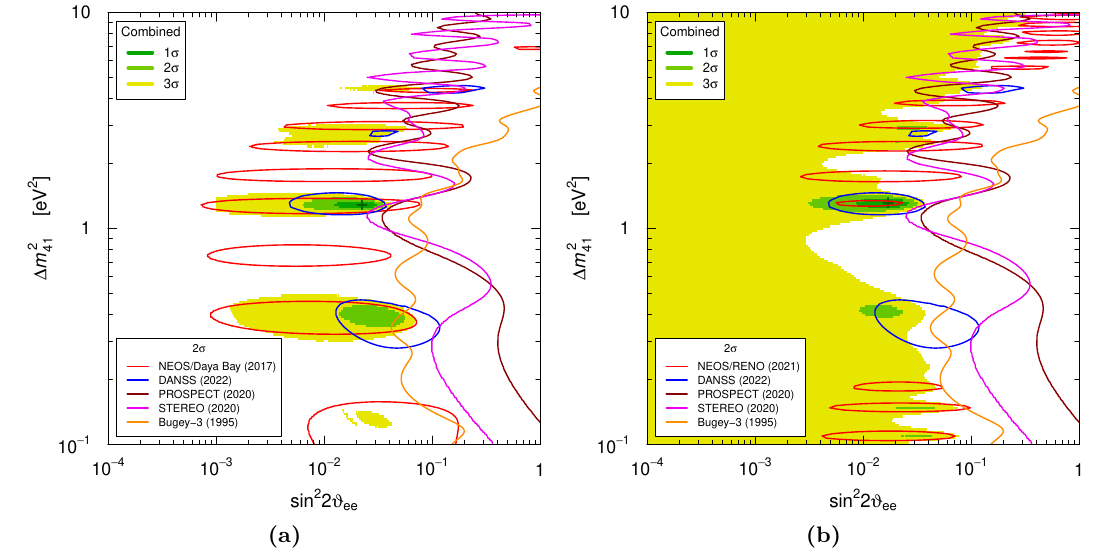
Figure 3. Allowed regions in the ( sin 2 2 ϑ ee , ∆ m 2 ) plane obtained from the combined analysis 41 of the (a) NEOS/Daya Bay [45] or (b) NEOS/RENO [46] spectral ratio data with those of the DANSS [40], PROSPECT [42], STEREO [44], and Bugey-3 [57] experiments. Also shown are the contours of the 2 σ allowed regions of each experiments. Closed contours surround the allowed region and open contours exclude the region on the right.